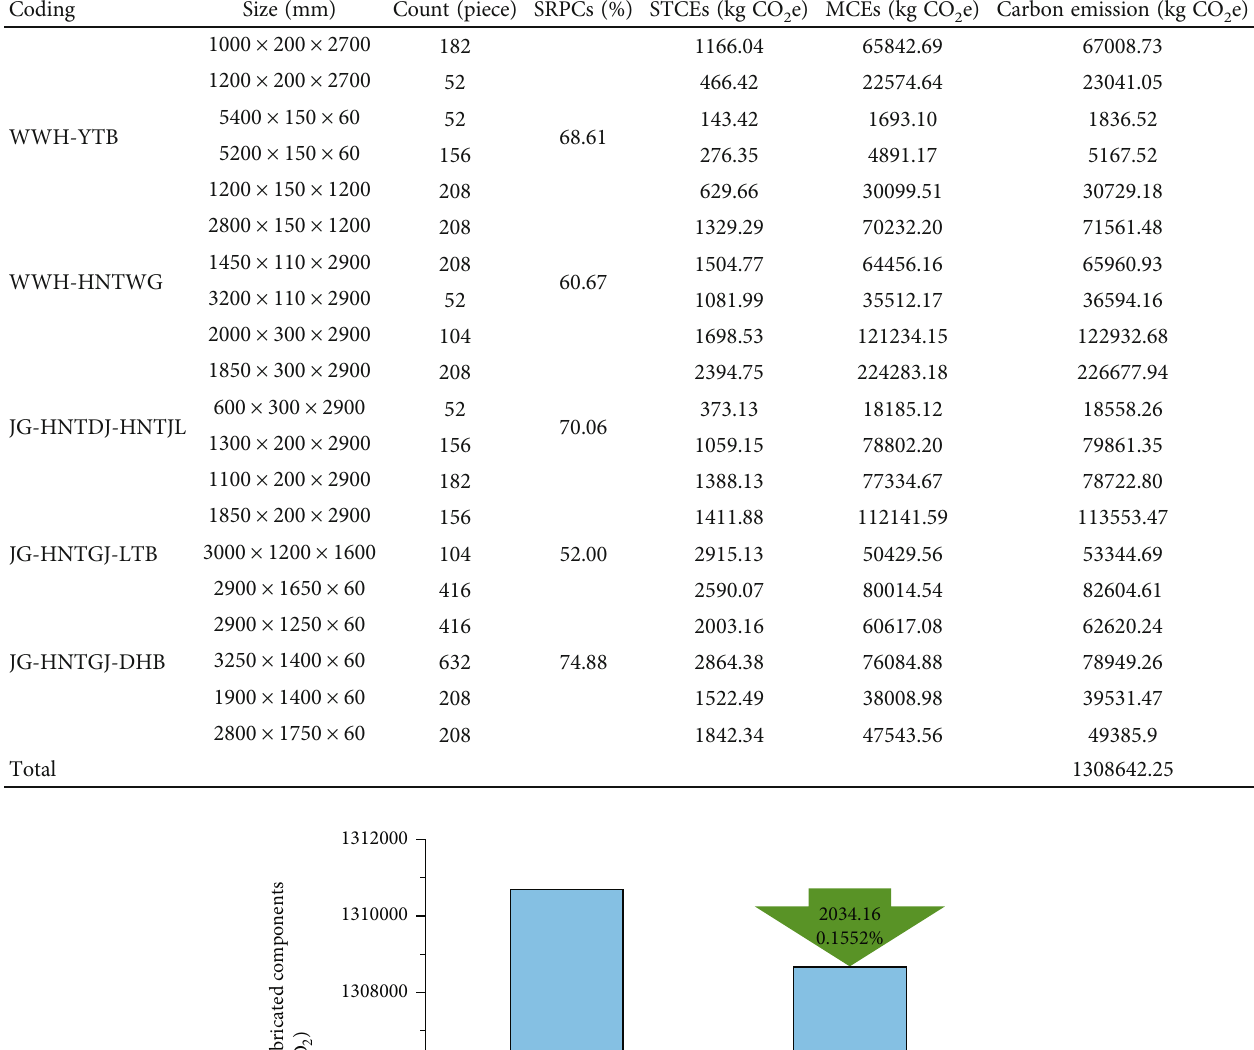
Table 4: Prefabricated component carbon emissions of alternative solutions to optimize architectural design.